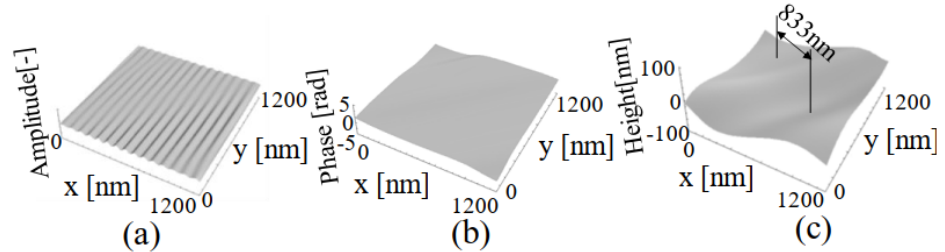
Figure 7. Two-dimensional analysis. ( a ) Modulated carrier fringes; ( b ) Phase distribution as the differential value of shape; ( c ) Measured shape distribution.